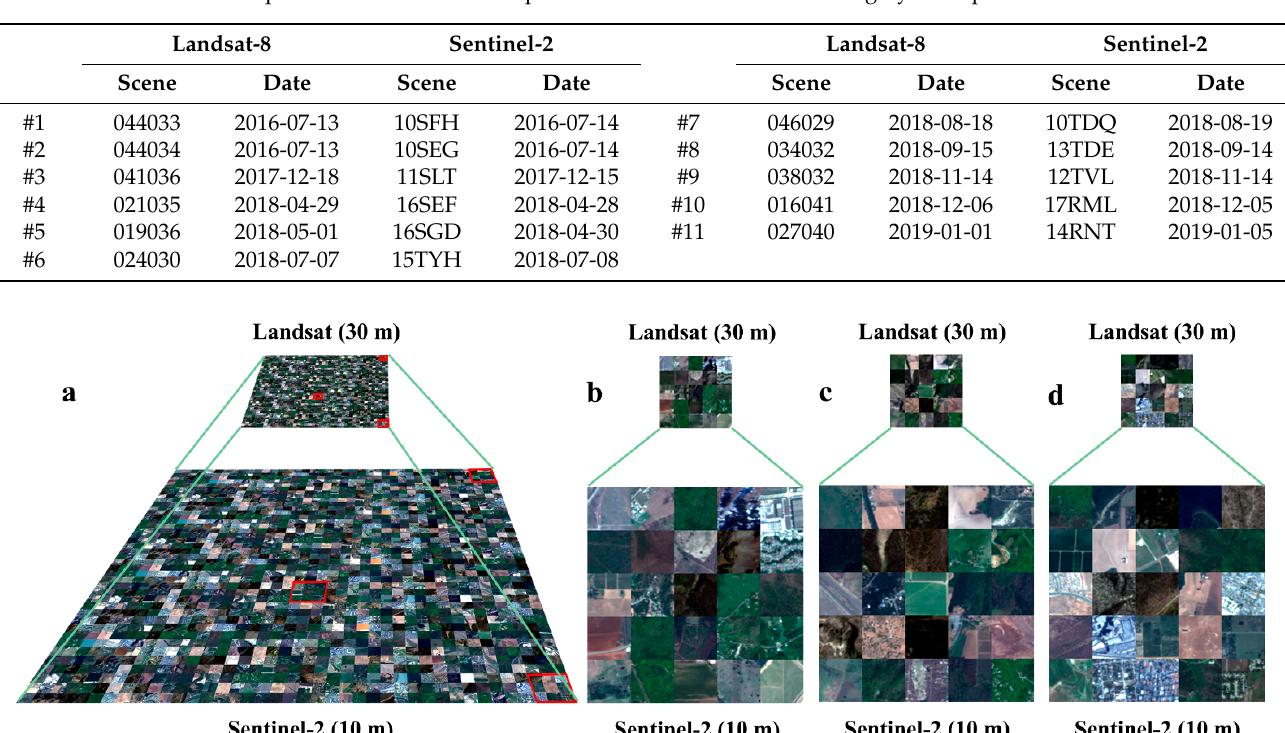
Table 1. Acquisition tiles and dates of paired Landsat and Sentinel-2 imagery for experimental tests.